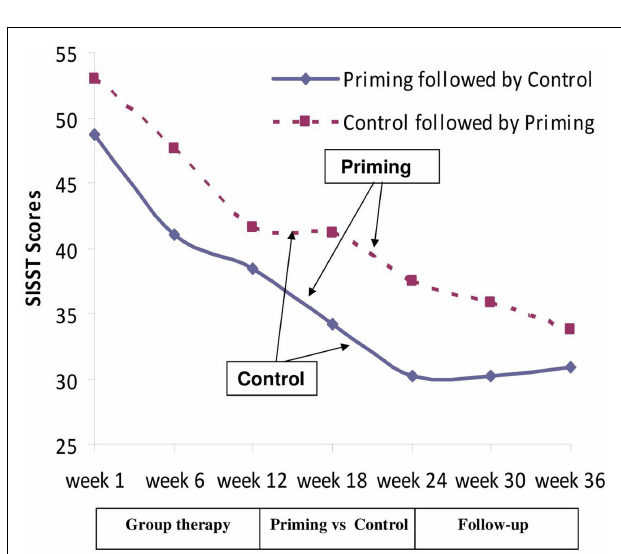
FIGURE 3 | Changes in SISST negative statements scores through the 36weeks of the study.